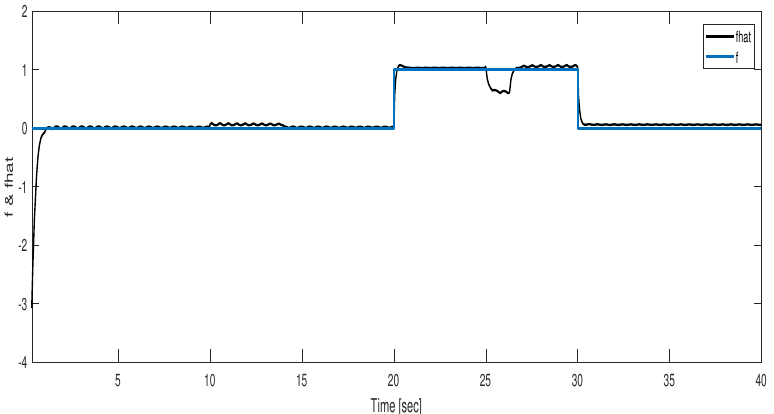
Figure 1. Illustration of robust actuator fault reconstruction (fault on the first actuator).